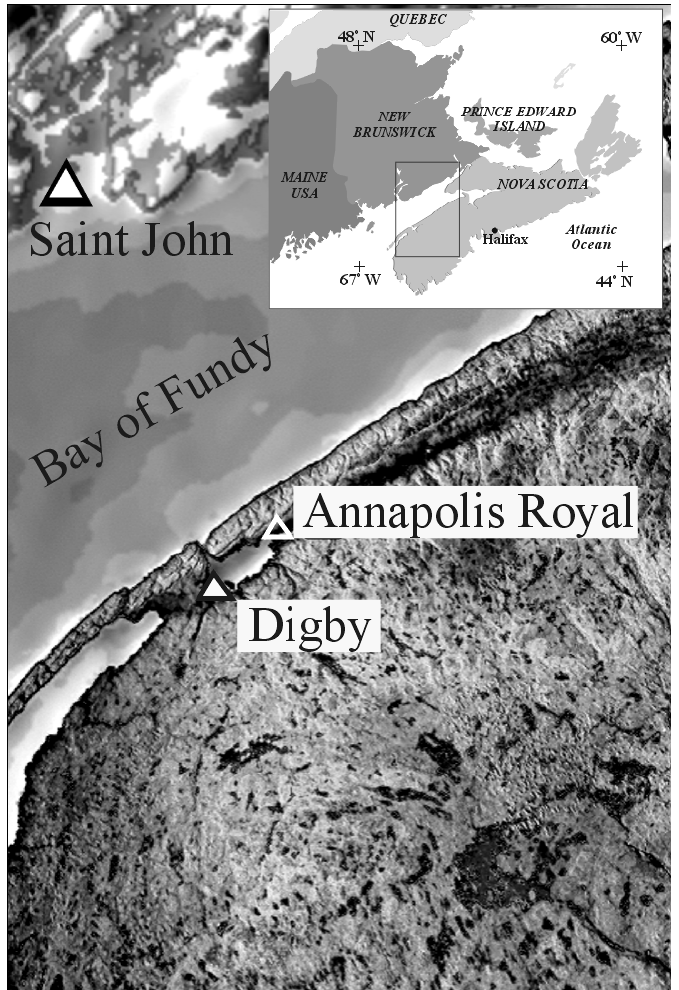
Figure 1. Location of the study area, Annapolis Royal, and the nearest long-term tide gauge; Saint John. Digby is directly west of the Annapolis Royal label on the